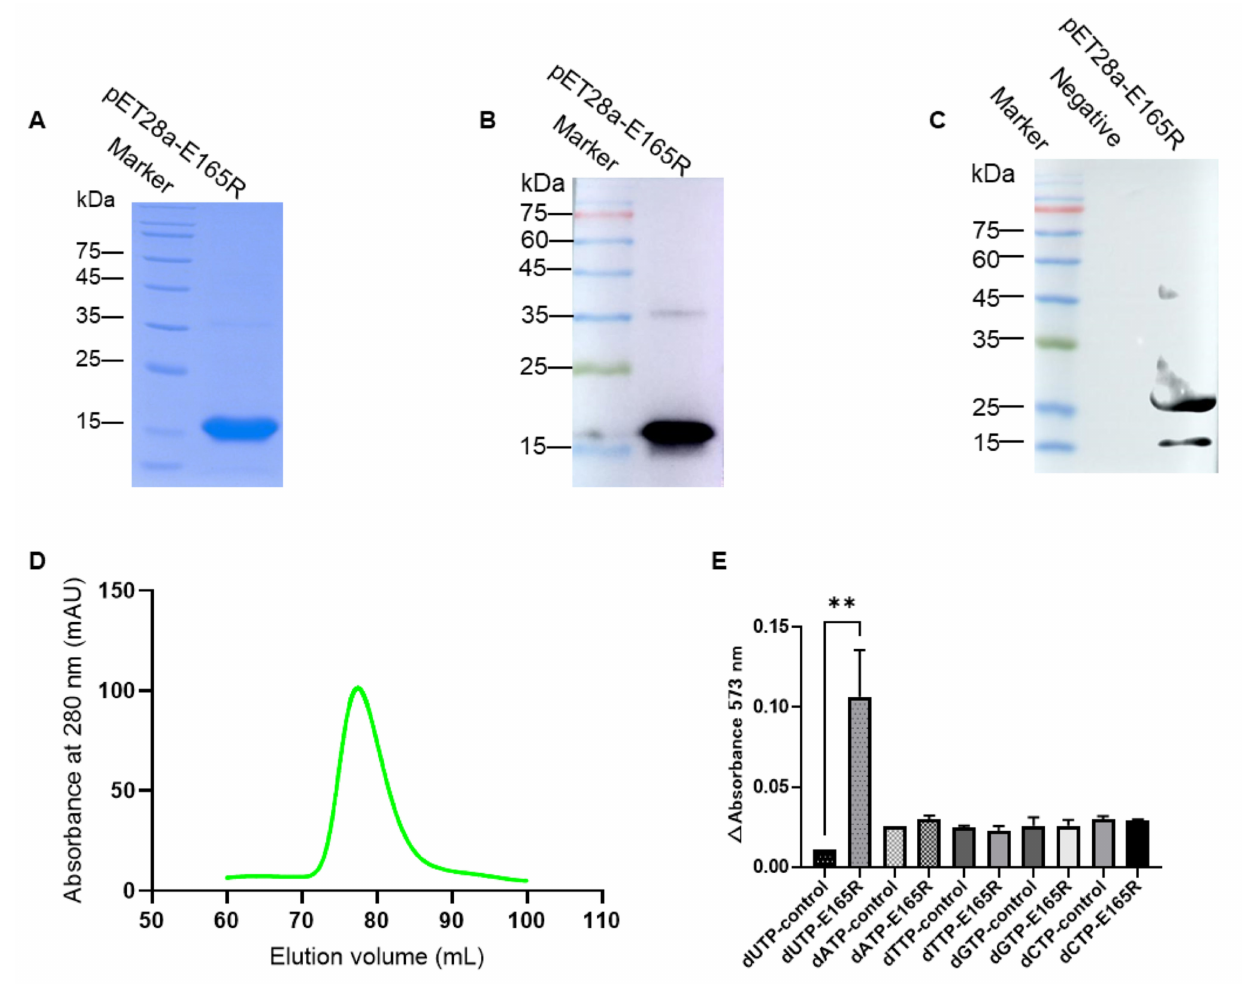
Figure 1. Identification of the immunogenicity and specificity of recombinant E165R (dUTPase) protein. ( A ) Analysis of purified E165R protein by HisTrap FF. ( B ) Identification of expressed recombinant E165R using mAb against His-tag by Western blotting. ( C ) Identification of expressed recombinant E165R using ASFV-positive serum by Western blotting. ( D ) Analysis of purified E165R protein by gel-filtration chromatography. ( E ) Enzyme activity and substrate specificity of full-length recombinant E165R (dUTPase). Note: “**” means the difference is significant at the 0.01